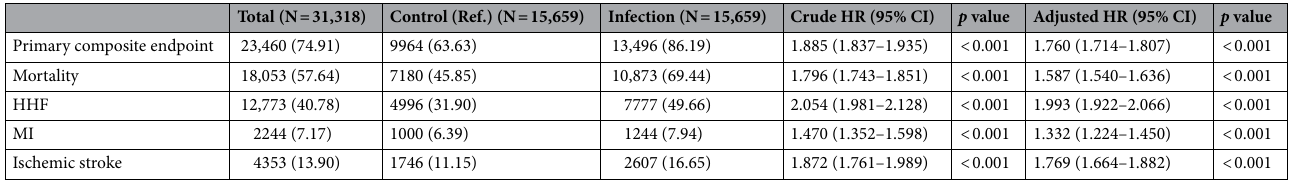
Table 2. Clinical outcome of infection versus control group. Model was adjusted for age, sex, comorbidities, procedure history, medication history. HR hazard ratio, HHF hospitalization for heart failure, MI myocardial infarction.